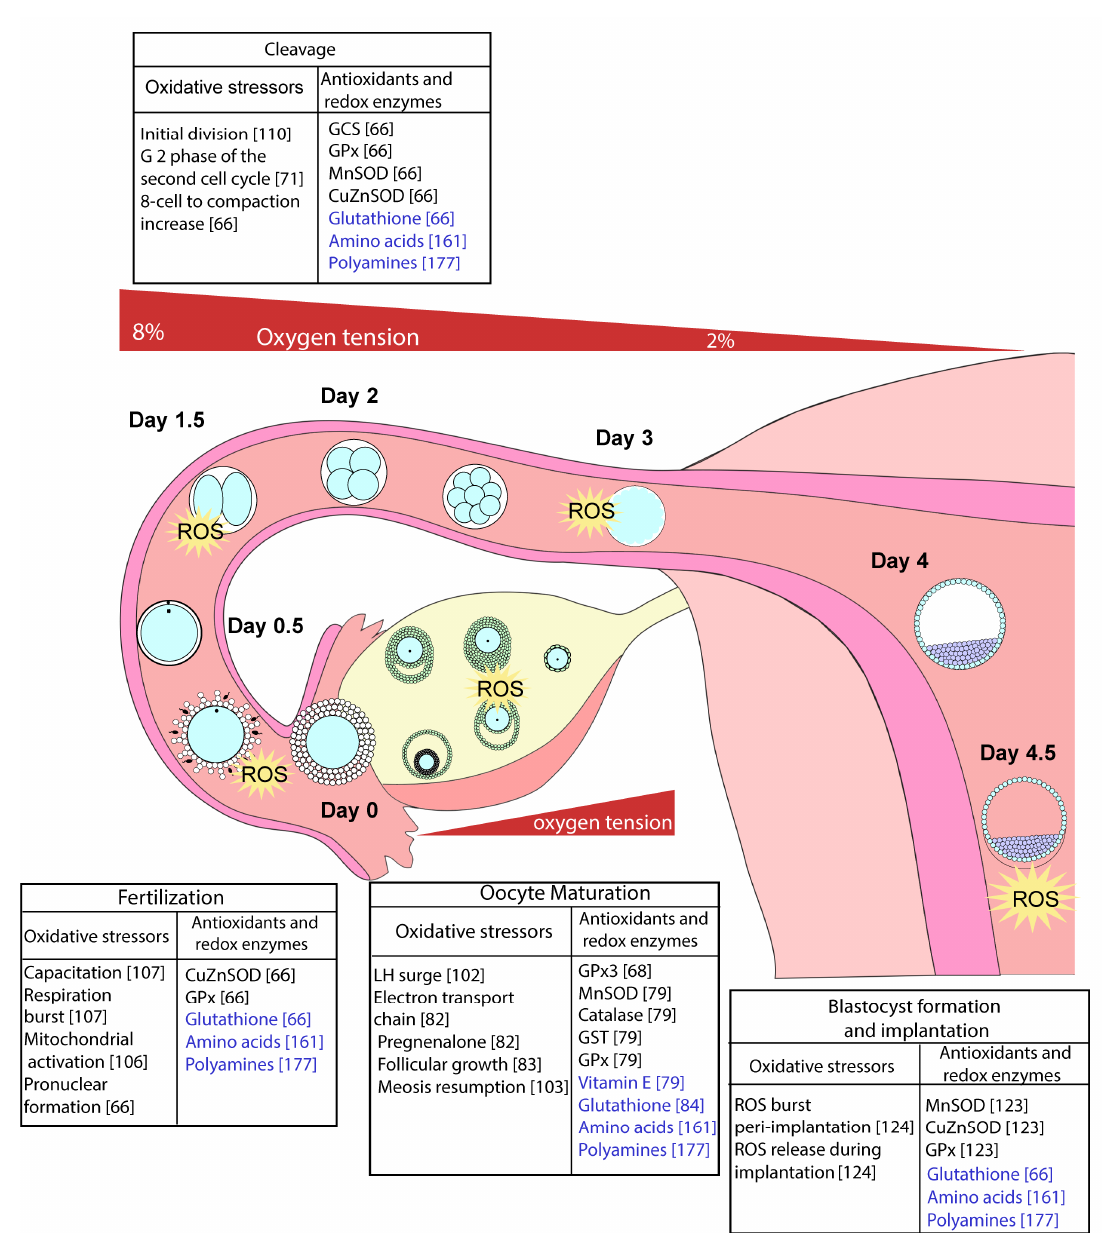
Figure 3. Sources of ROS and antioxidants during in vivo embryo development. The preimplantation embryo develops over 5 days in the mouse in vivo. The maternal reproductive tract is an environment low in oxygen, with an oxygen gradient of approximately 8% to 2% from the oviduct to the uterus. This, along with a number of antioxidants and antioxidant enzymes, supports redox homeostasis and helps prevent irreversible oxidative damage. During oocyte maturation and preimplantation embryo development, there are numerous oxidative stressors including at ovulation, fertilisation, cellular division, and hatching. Some examples of the control of the action of these stressors by redox enzymes (in black) and antioxidants (in blue) are shown. References are shown in square brackets.